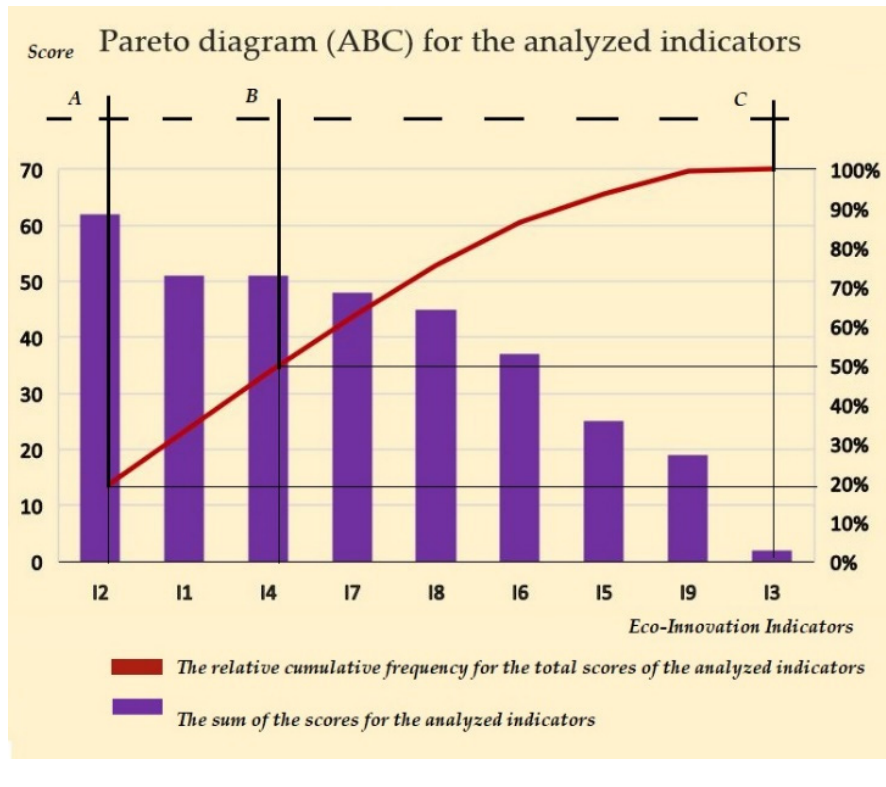
Figure 8. Pareto ABC diagram of indicators (Authors’ own source).